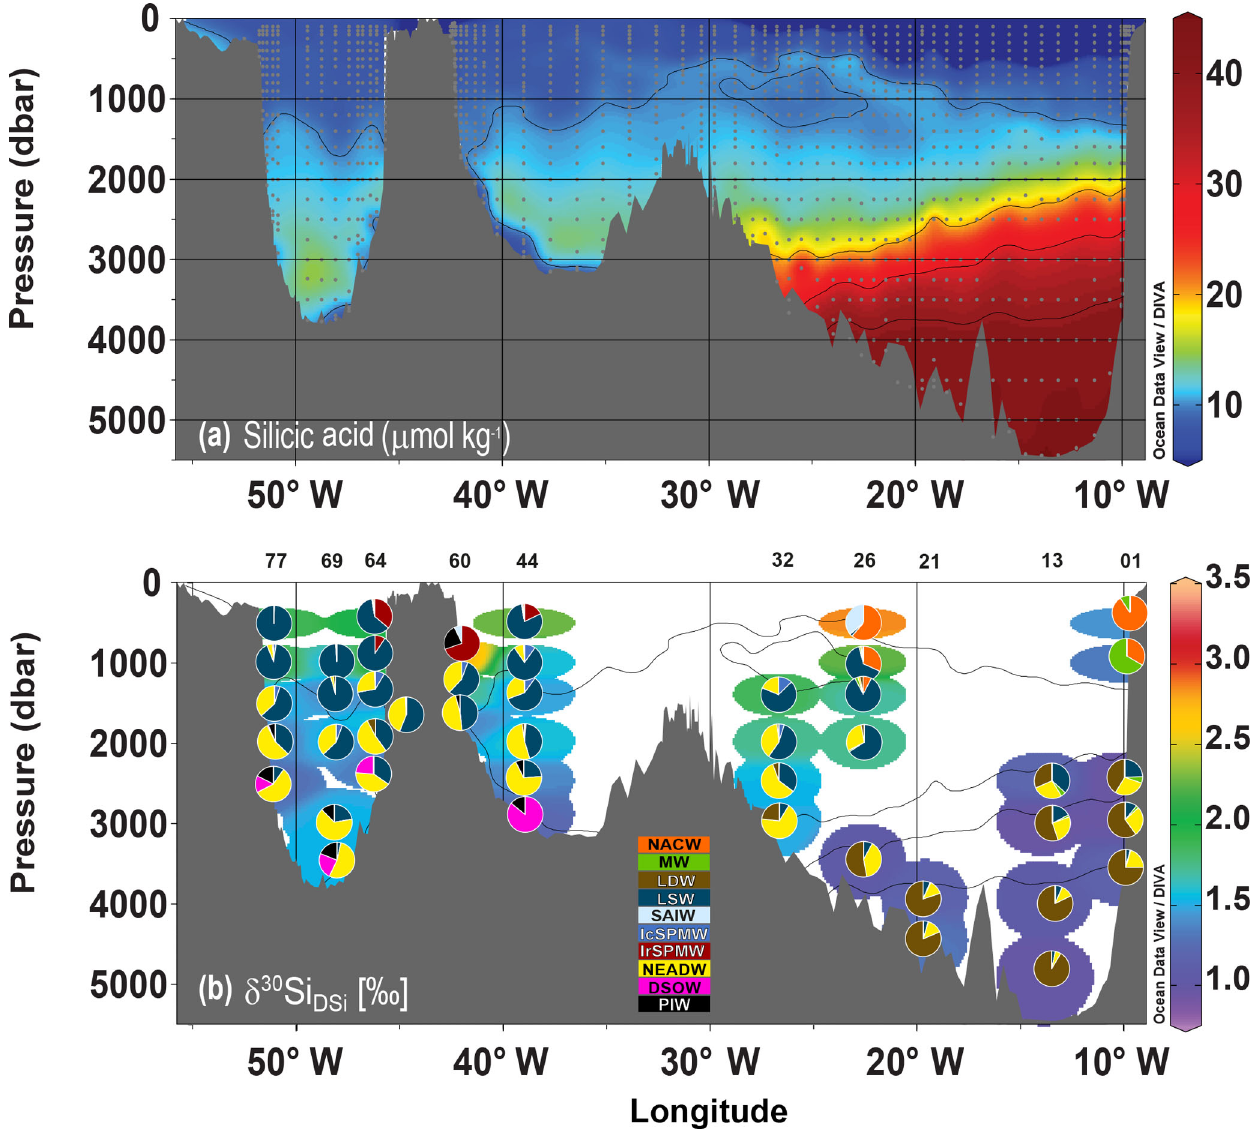
Figure 5. Depth section across the GEOVIDE transect with (a) silicic acid concentration (dissolved silicon; DSi) together with (b) δ 30 Si DSi data overlain by pie charts of the fraction of DSi in each sample contributed by various water masses, as calculated by OMP analysis (García- Ibáñez et al., 2018). Spreading of Labrador Sea Water, as shown in Fig. 4 and in the OMP results (see Supplement Table S4) by a dominant Si contribution from this water mass, produces a mid-depth extension of elevated δ 30 Si values into the eastern Atlantic. For water mass abbreviations see the main text (Sect.